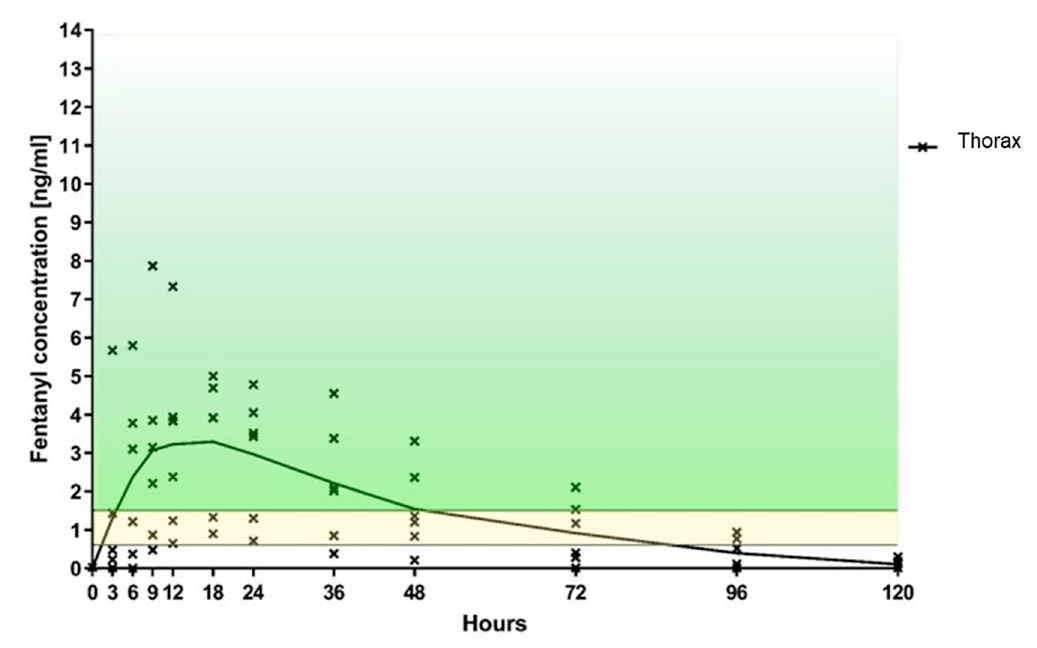
Figure 5. Thorax — Fentanyl plasma level over time (the fentanyl level within the area marked in yellow, correspond to the minimal analgesic plasma level of 0.6–1.5 ng/mL described for humans; the area above marked in green represents values higher than 1.5 ng/mL).